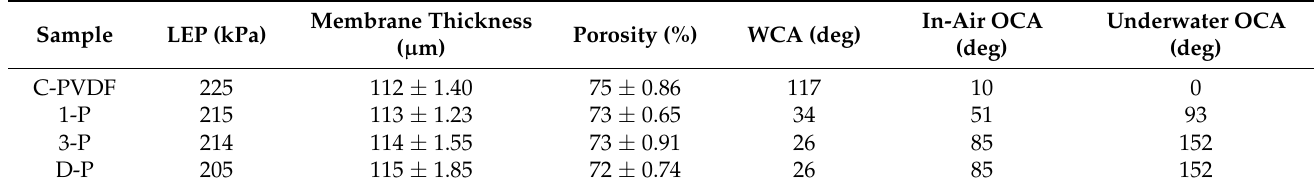
Table 1. Physical characteristics of the inkjet-modified and commercial